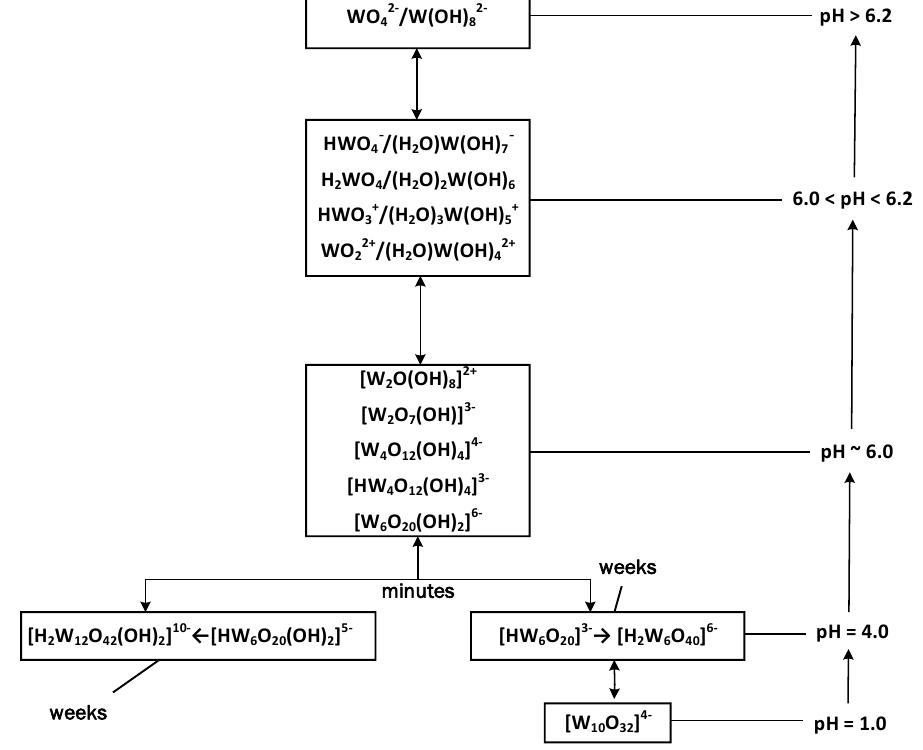
Figure 1. Tungsten speciation as a function of pH [16]. Table 1. Chemistry of tungsten minerals. Based on: